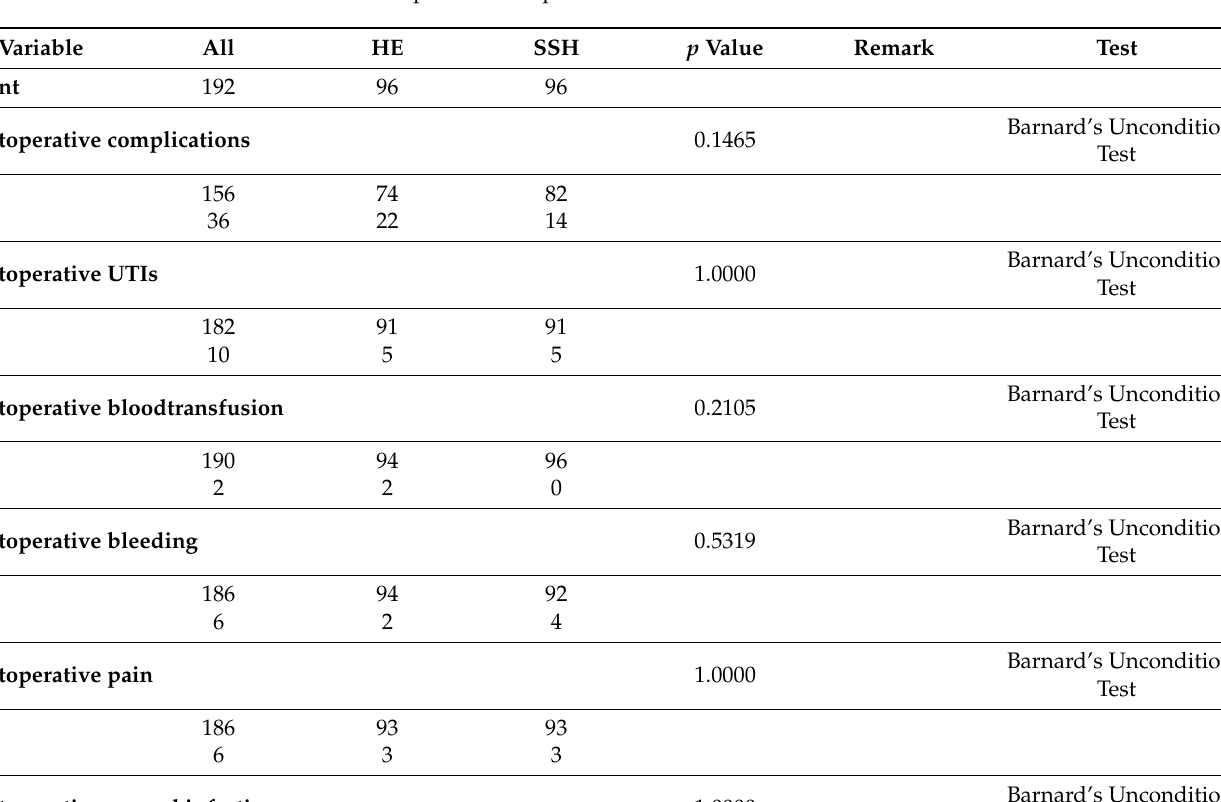
Figure 5. Postoperative complication after Clavien–Dindo classification. Figure 5 . Postoperative complication after Clavien–Dindo classification . Table 3. Postoperative complications and